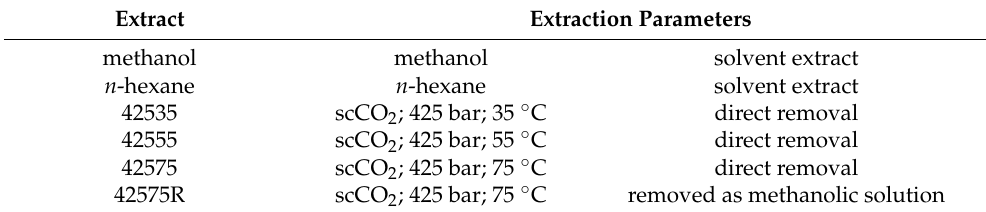
Table 2. Characteristics of the extracts monitored in the stability study. Extract Extraction Parameters